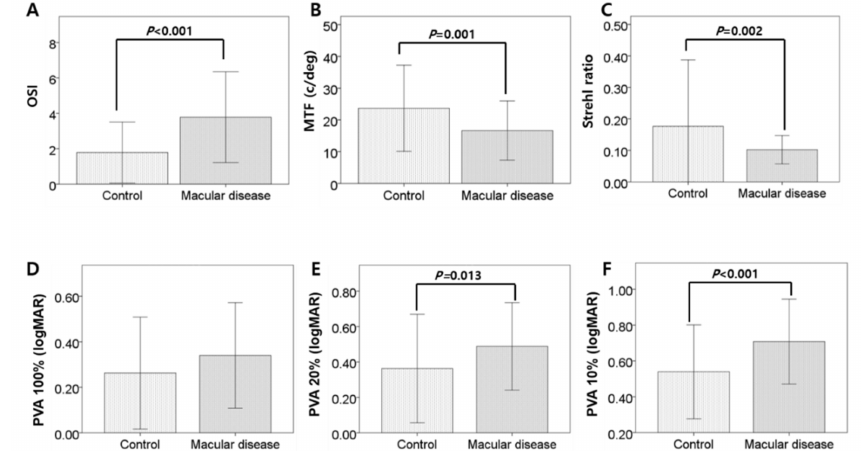
Figure 1. Comparison of parameters of optical quality in both groups. A, B, C . The group of macular disease had significantly higher mean OSI, lower mean MTF, and lower mean Strehl ratio. D, E, F . Predicted visual acuities (PVA) at 10% and 20% contrast levels showed significantly higher in the macular disease, but no significant di ff erence at 100% contrast. P-value is presented if it isstatistically significant by independent t -test. Error bars represent standard deviation